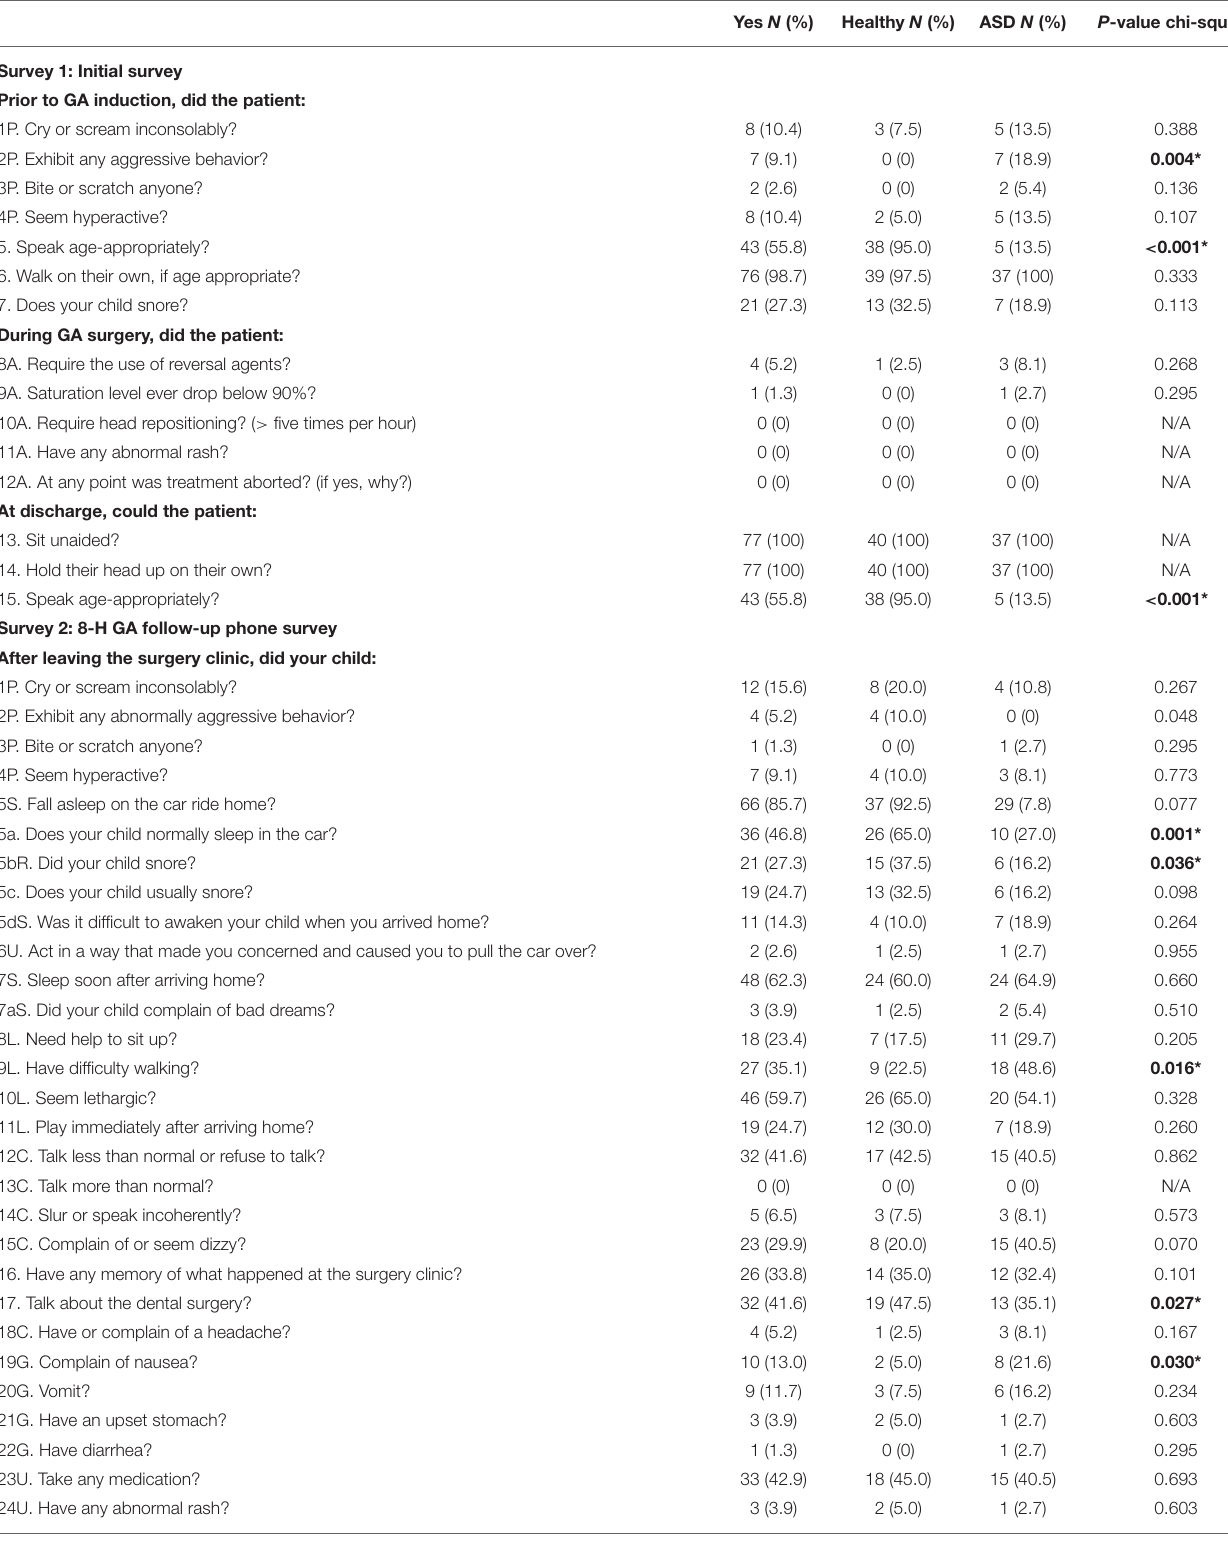
TABLE 2 | Survey questions comparing incidence of adverse behavioral events after GA.